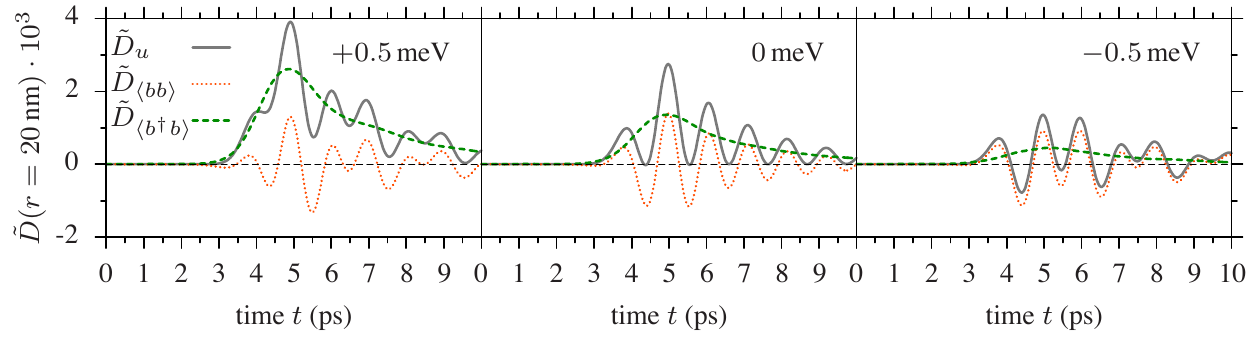
Figure 3. Fluctuations of the lattice displacement ˜ D ˜ D (dotted orange) and the phonon occupation ˜ D bb (cid:104) (cid:105) (center), +0 . 5 meV (left) and